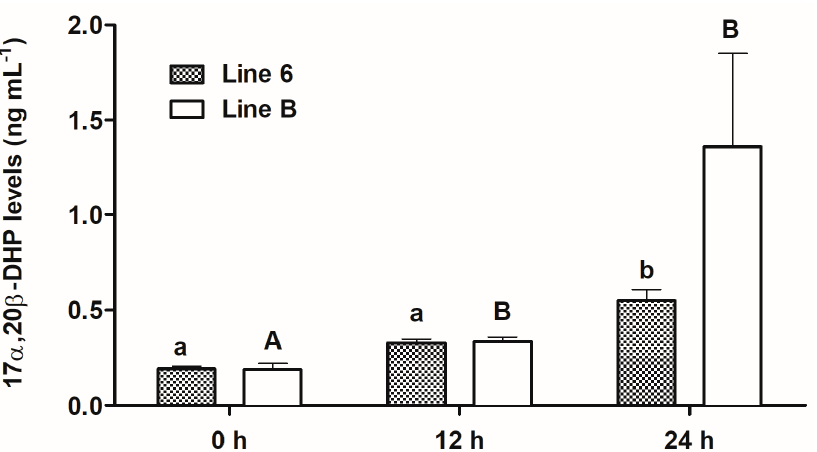
Figure 4. Plasma 17 α ,20 β -DHP levels in blood samples taken from females from two breeding lines of common carp, i.e., Polish line 6 ( n = 15) and Lithuanian line B ( n = 13) before the first injection of Ovopel (0 h) and 12 and 24 h post-injection (12 and 24 h). Different lowercase letters indicate significant differences between sampling times within line 6. Different uppercase letters indicate significant differences between sampling times within line B ( p ≤ 0.05). Differences between lines within sampling times were non-significant.